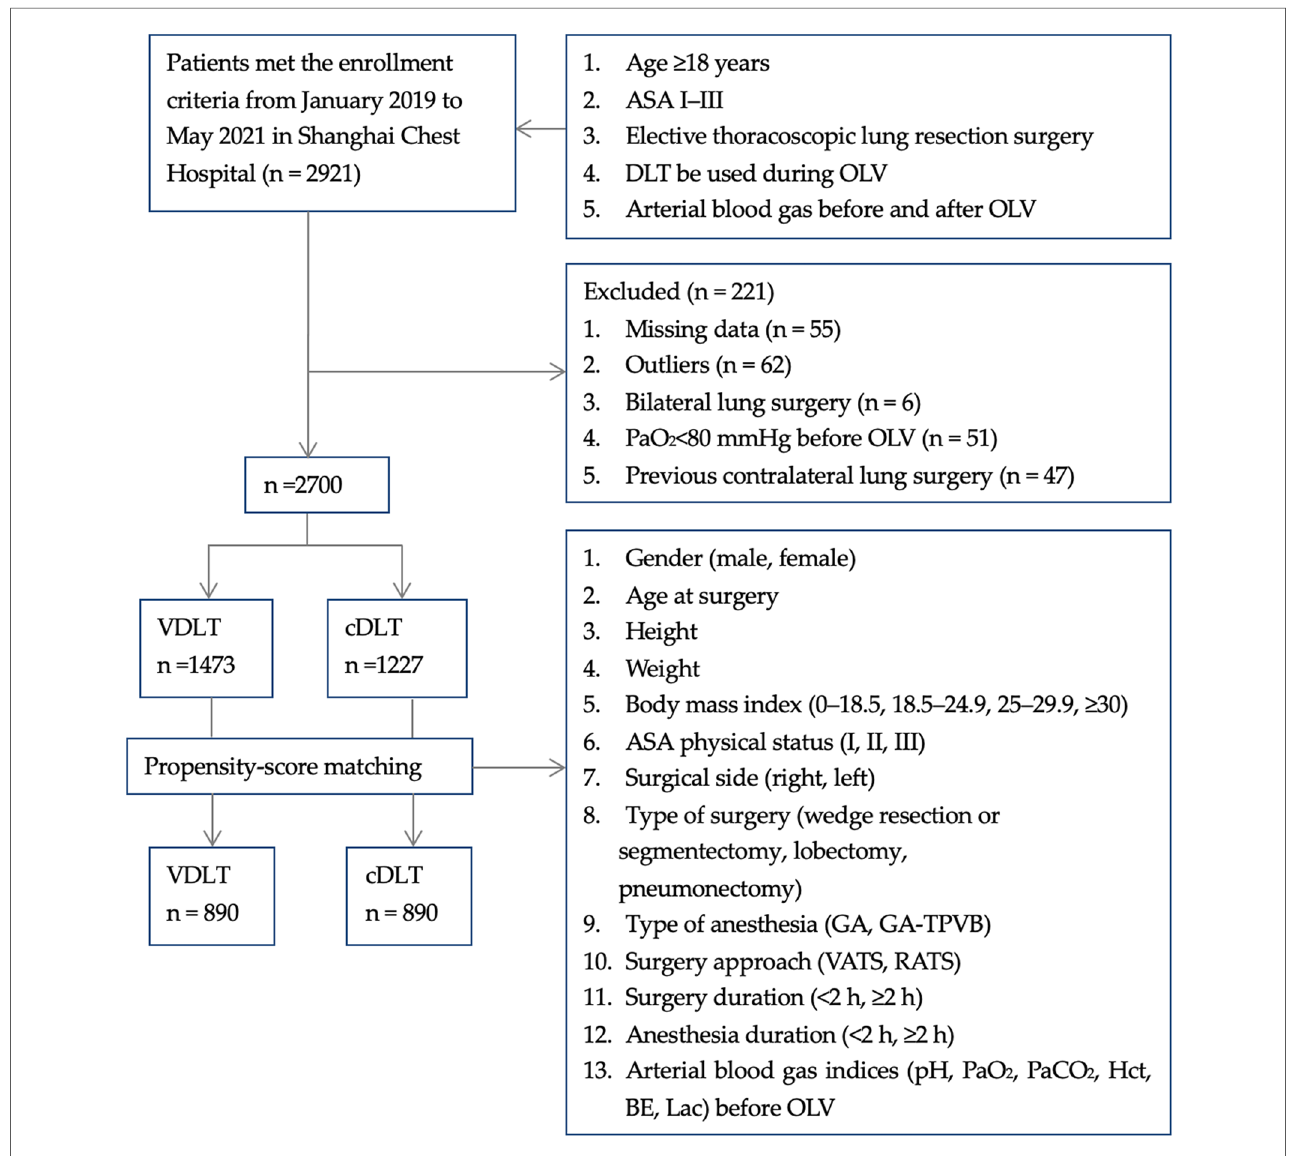
FIGURE 2 Flow chart for the inclusion and exclusion of